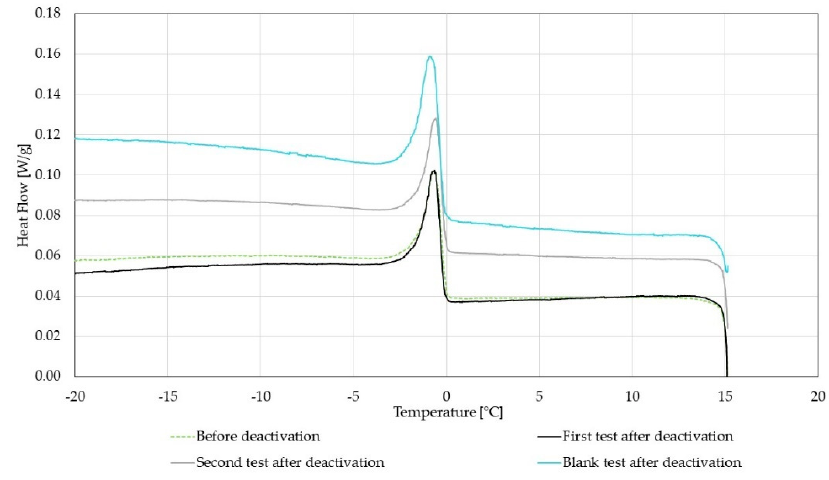
Figure 18. Differential scanning calorimetry of average sample prior to deactivation and three samples after accelerated and spontaneous deactivations. Table 5. Comparison of the results of the spent catalyst.